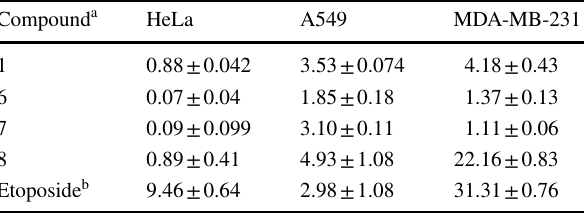
Table 3 Cytotoxicity of the isolates on three cancer cell lines with IC 50 values ( μ